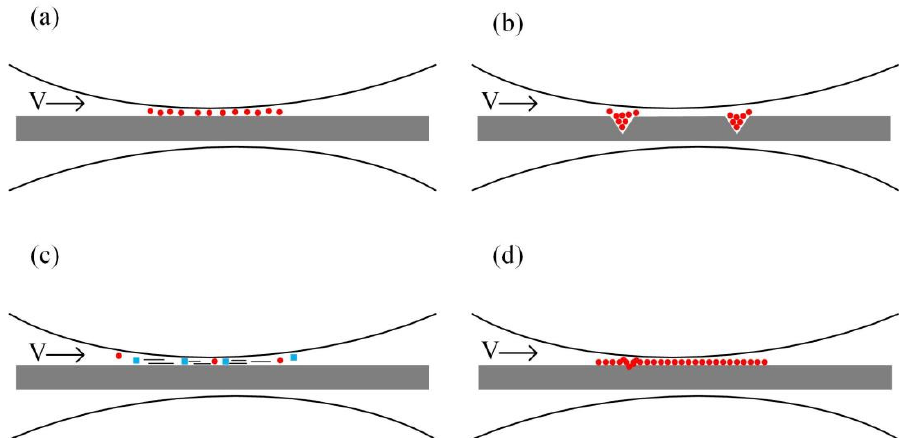
Figure 11. The schematic diagrams of the lubrication mechanism of TiO 2 nano-additive water-based lubricants: ( a ) rolling effect, ( b ) mending effect, ( c ) polishing effect and ( d ) protective film.